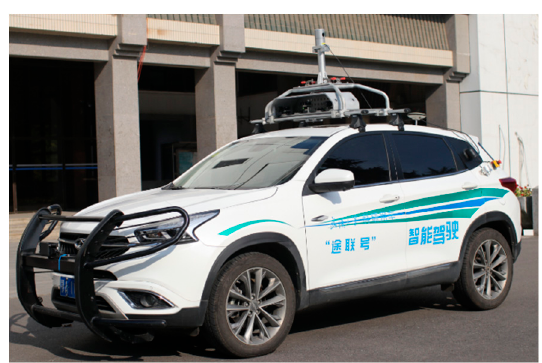
Figure 7. Autonomous vehicle equipped with positioning equipment for experiment.